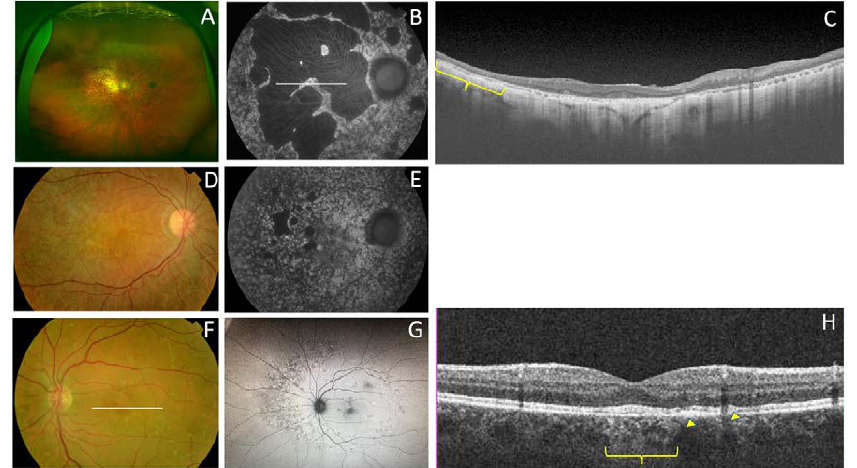
Figure 10. The clinical features of family 4 (p.Gly167Ser). ( A ) The fundus appearance of a case from F4-III-1 shows large confluent areas of chorioretinal atrophy and pigment clumps in mid-periphery, ( B ) AF images with a large area of hypoautofluorescence and speckled points of hypo-AF in the posterior pole and mid-periphery, and ( C ) SD-OCT shows areas of outer retinal atrophy (yellow brace). ( D ) The fundus images obtained from F4-IV-1 show whitish stippling over the posterior pole and ( E ) speckled points of hypo- and hyper-AF in the posterior pole and mid-periphery are seen in her AF. ( F ) The fundus features from F4-IV-2 show yellow triradiate flecks in the posterior pole, ( G ) AF images show scarce speckled hyper-AF and hypo-AF at the posterior pole and mid-periphery, and ( H ) SD-OCT images show disruption of the ellipsoid and interdigitation zones of the juxtafoveal region (yellow arrows) and foveal hypertransmissibility to the choroid (yellow brace).